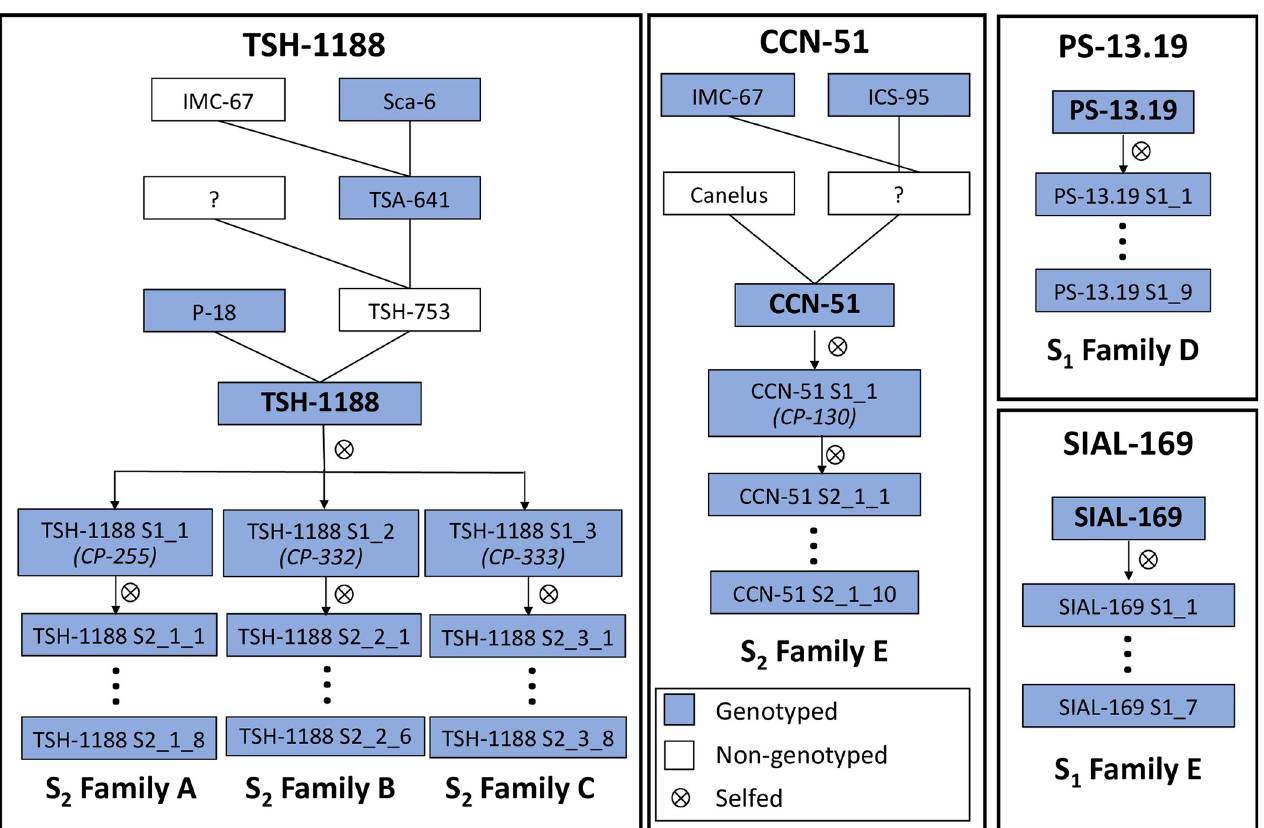
Fig 1. Pedigrees of the six partially inbred families obtained from self-pollination of four cacao clones (TSH-1188, CCN-51, PS-13.19, SIAL-169).